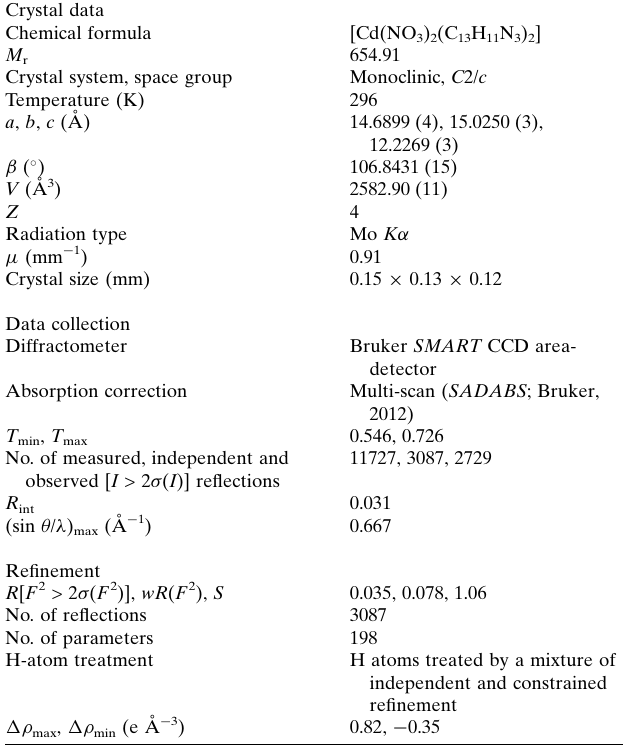
Table 2 Experimental details. Crystal data Chemical